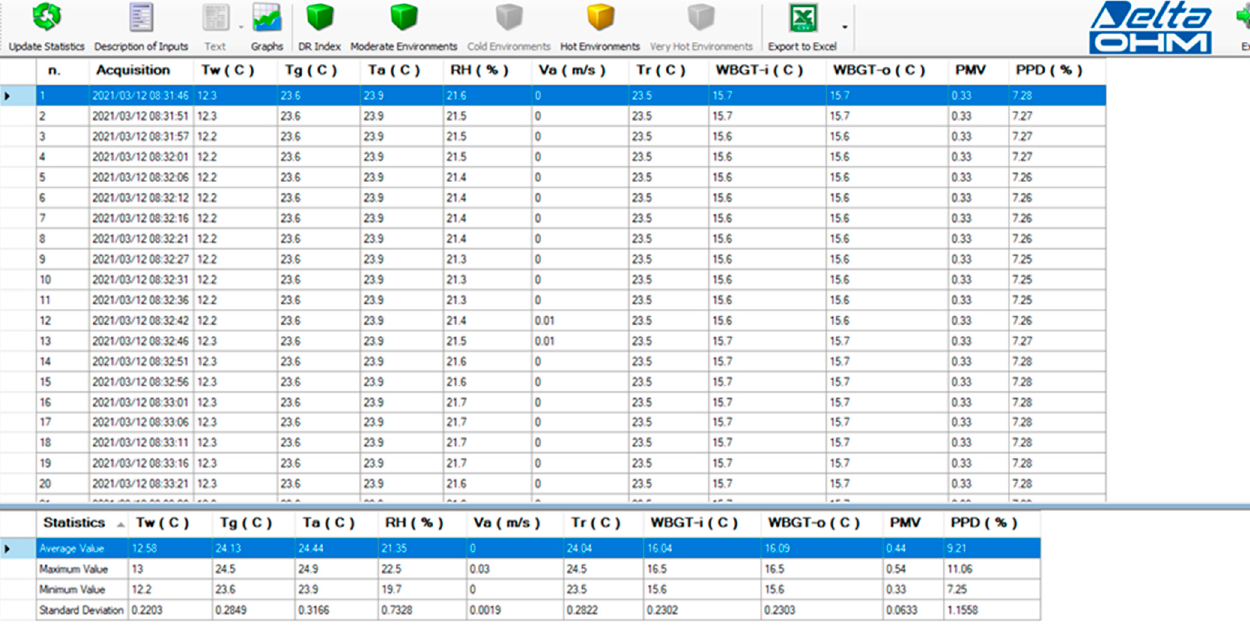
Figure A3. Screen capture of DeltaLog 10 software presenting the thermal sensation assessment based on PMV and PPD indices.